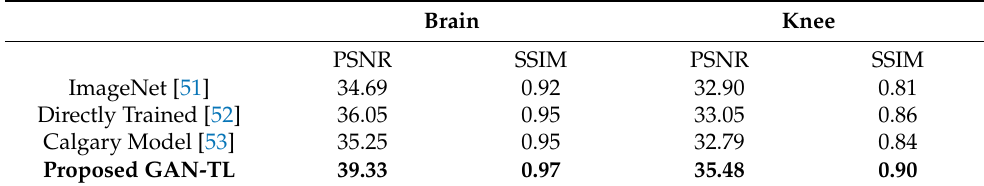
Table 3. PSNR and SSIM quantitatively evaluated values for the brain and knee test images acquired using various reconstruction models after using transfer learning.